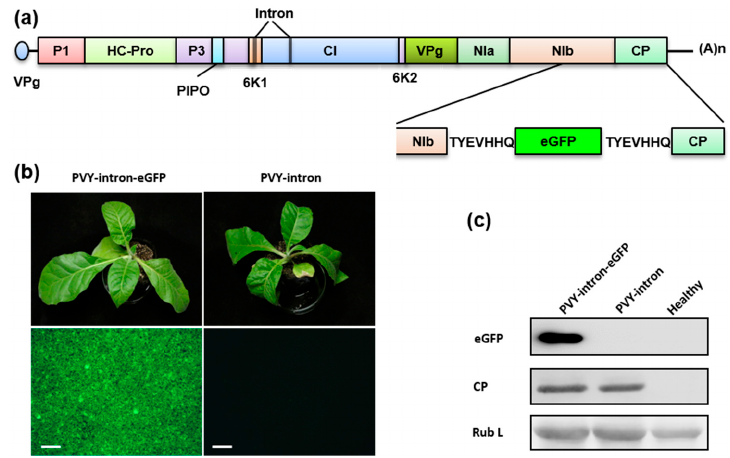
Figure 4. Construction of an eGFP-tagged PVY intron-containing infectious cDNA clone: ( a ) Schematic representation of the eGFP insertion; ( b ) Symptoms and eGFP expression of PVY-intron-GFP and PVY-intron infected N. tabacum plants. The upper panels show symptomatic plants photographed at 15 days post infiltration and the lower panels show eGFP expression in systemically infected leaf tissues observed by fluorescence microscope; ( c ) Total proteins extracted from systemically infected plants or un-infiltrated control plants were analyzed by Western blotting using an antibody against the PVY coat protein (CP). The Coomassie blue-stained Rubisco large subunit (Rub L) is showed as a loading control.